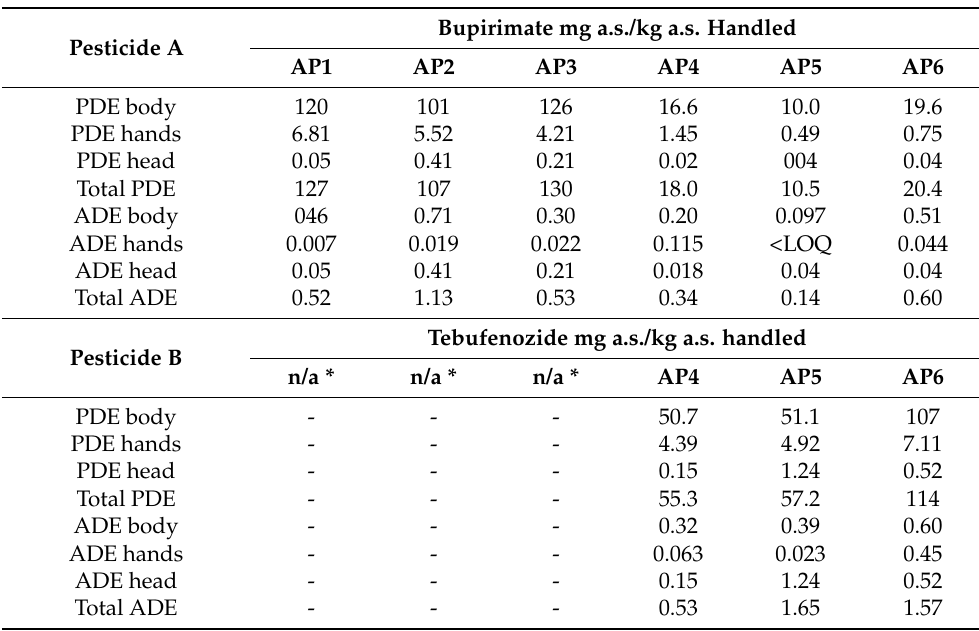
Table 7. PDE and ADE values for applicators (mg a.s./kg a.s.